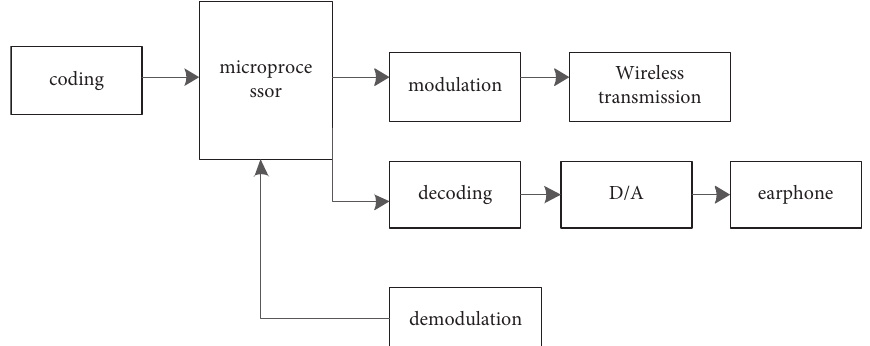
Figure 5: Block diagram of transliteration